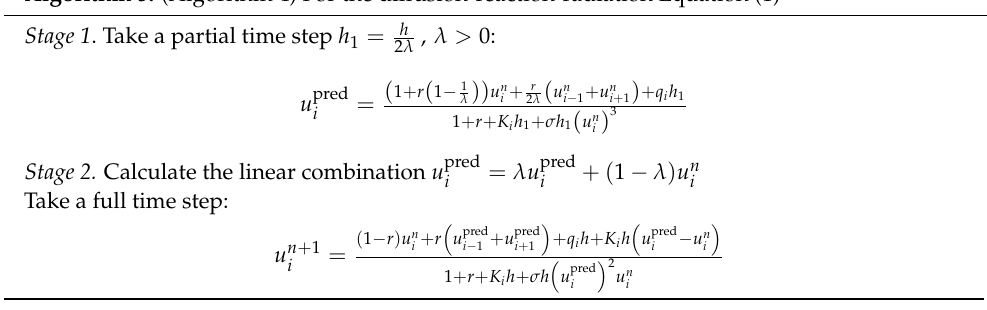
Algorithm 5: (Algorithm 4) For the diffusion-reaction-radiation Equation (1)